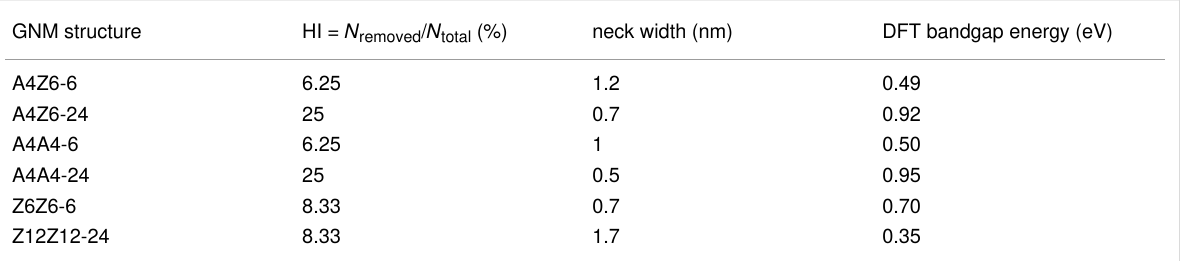
Table 1: Calculated energy gaps for GNMs with hydrogen passivation of carbon atoms in proximity to the holes. GNM structure